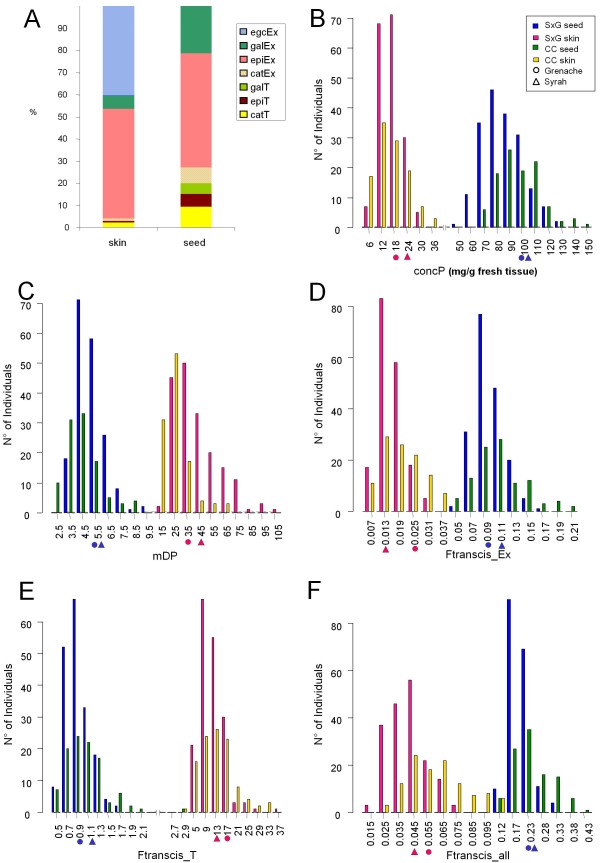
Comparative composition of skin and seed PA in 2006 (A) and distribution of PA variables of S × G and CC populations in 2006 for concP (B), mDP (C), Ftranscis_Ex (D) Ftranscis_T (E) and Ftranscis_all (F). (A) PA composition in skin and seeds based on the S × G offspring average is shown. Each building block is presented as the offspring average percentage of total content. (B-F) Distribution of PA variables in S × G and CC populations in 2006. Upper limits of data interval are indicated under the x-axis. Full symbols near x-axis show mean parental values for S × G population, circle for Grenache and triangle for Syrah, in pink for skin values and in blue for seed value as for the offspring histograms.